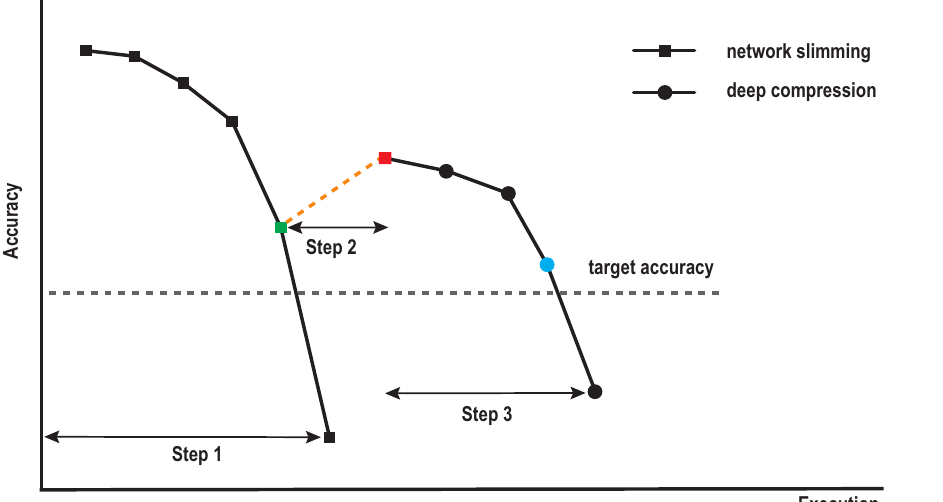
Figure 5. Compression iterations of our proposed method during the search process for the minimal accuracy. Step 1 is the iteration to find the minimal model by structured pruning. Step 2 is the iteration defined by the margin. Step 3 is the iteration to find the minimal model by the unstructured